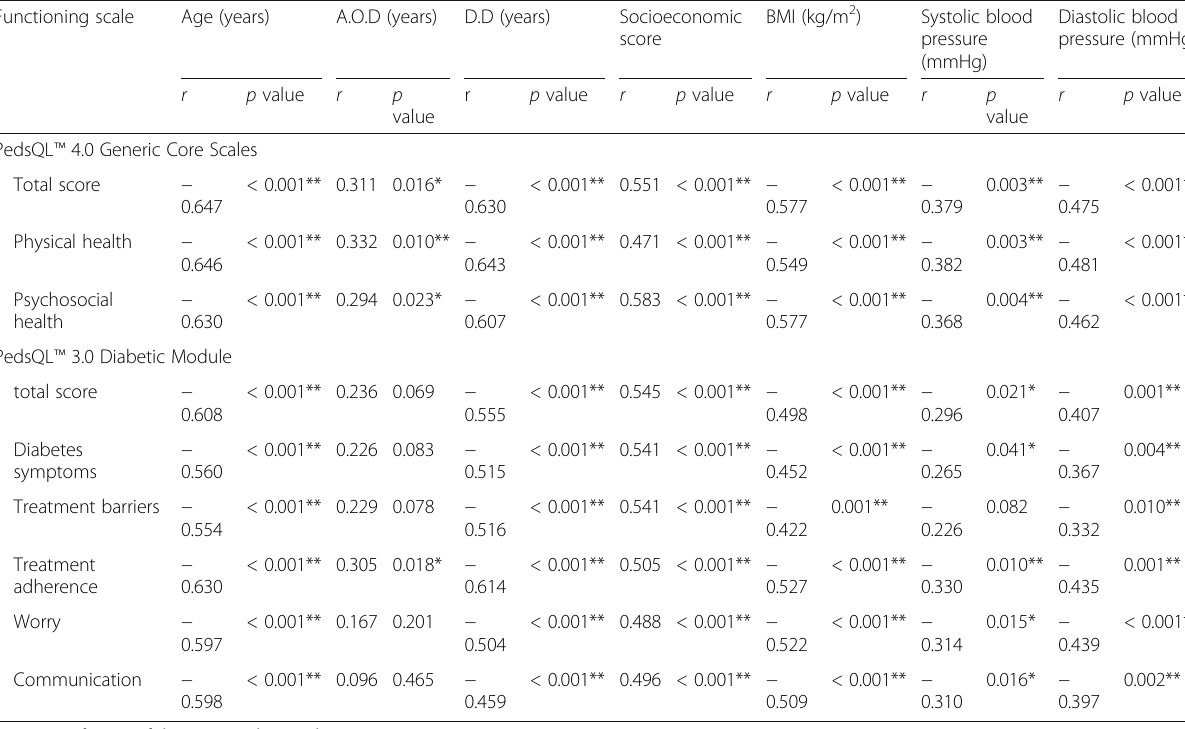
Table 6 Correlation between Pediatric Quality of Life Inventory scores with demographic and clinical characteristics in the studied diabetic patients